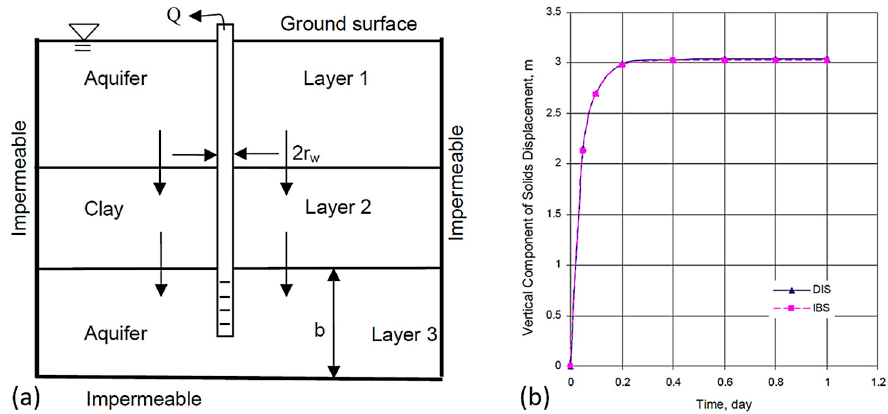
Figure 4. ( a ) Conceptual model to evaluate subsidence calculated by DIS package (identical to NDIS with constant parameters) and IBS (Interbed Storage) package. ( b ) Comparison of vertical deformation calculated by the two models [19].